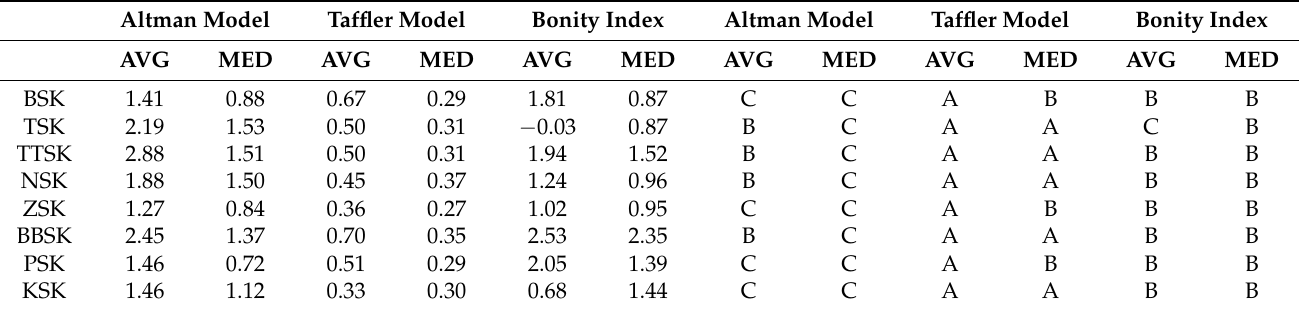
Table 4. Partial evaluation by Altman model, Taffler model, Bonity index at the level of individual regions—businesses. Altman Model Taffler Model Bonity Index